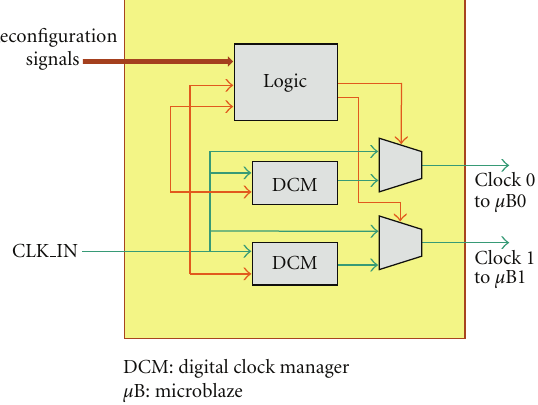
Figure 7: Internal structure of the reconfigurable clock